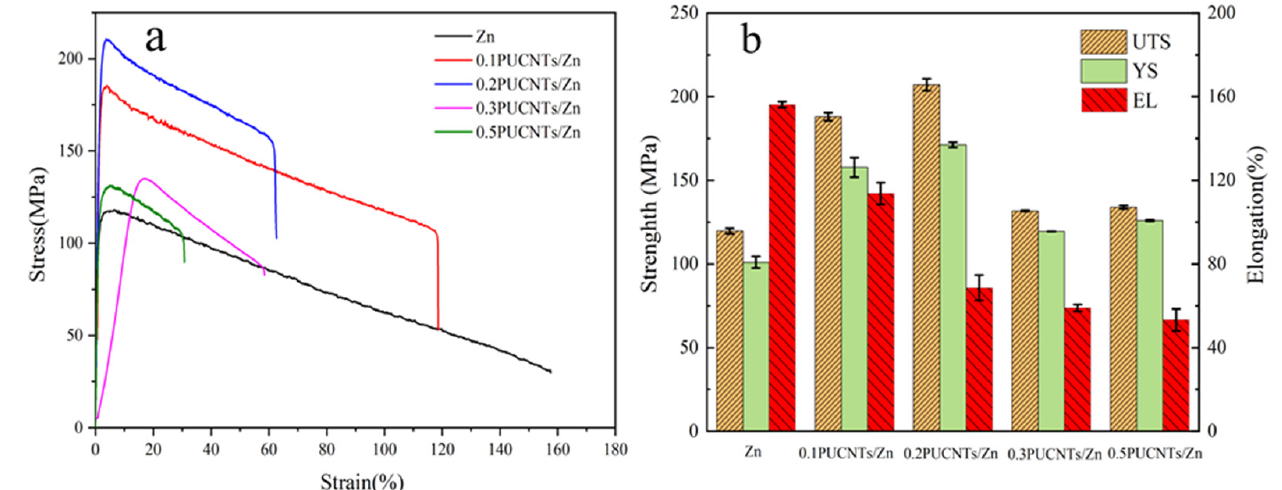
Figure 5. Mechanical properties of pure Zn and PUCNTs/Zn composites: ( a ) stress–strain curve; ( b ) tensile properties.